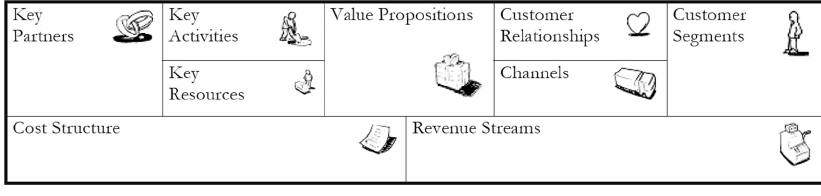
Table 4. TOWS analysis and strategy options.